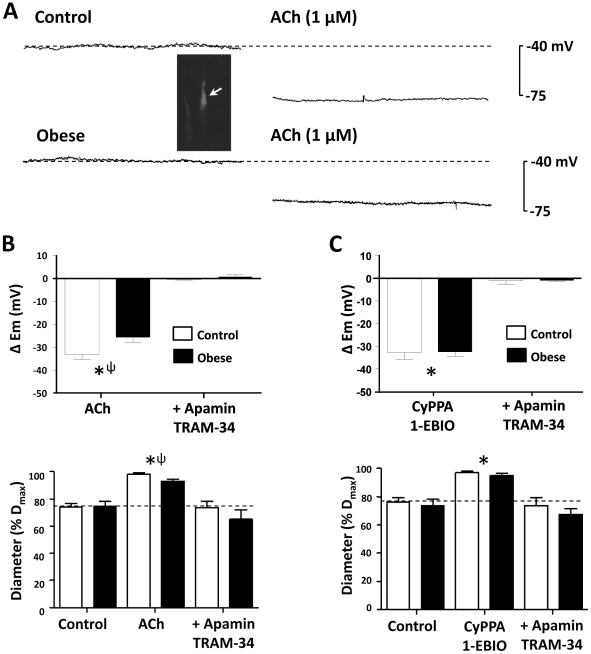
Combination SKCa and IKCa-mediated function.Representative membrane potential recordings show impaired hyperpolarization to ACh (1 µM) in pressurized obese, compared to control rat mesenteric artery (A, inset; impaled propidium iodide identified muscle cell; longitudinal vessel axis, left to right; bar, 10 µm). Hyperpolarization and relaxation to ACh were abolished by apamin (50 nM) and TRAM-34 (1 µM), confirming endothelium-derived hyperpolarization patency (B; Table S3). Hyperpolarization and relaxation could also be induced by the SKCa and IKCa agonists CyPPA (30 µM) and 1-EBIO (300 µM), with subsequent block by apamin and TRAM-34 (C; Table S3). Arteries from obese animals were further associated with a constriction beyond resting tone (B, C). *P<0.05 from own control; ψ, P<0.05 control compared to obese. ΔEm, change in membrane potential from own control.